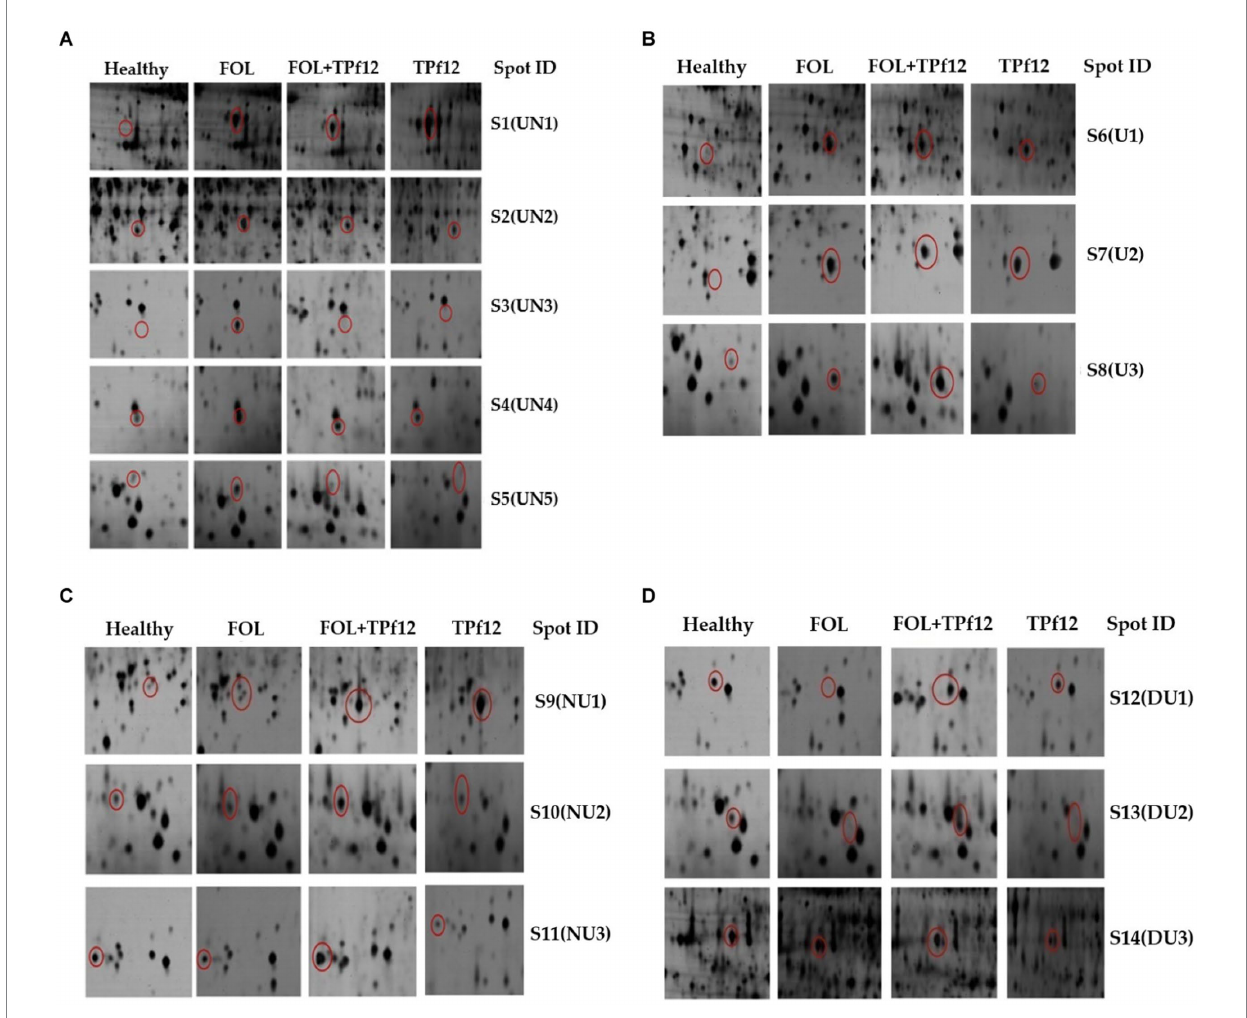
FIGURE 10 Protein expression patterns in tomato roots under different interactions by 2D-PAGE. (A) Upregulated in FOL and no change in triadic interaction (UN); (B) Upregulated in both FOL and triadic interaction. (C) No change in FOL and upregulated in triadic interaction (NU); (D) Downregulated in FOL and upregulated in triadic